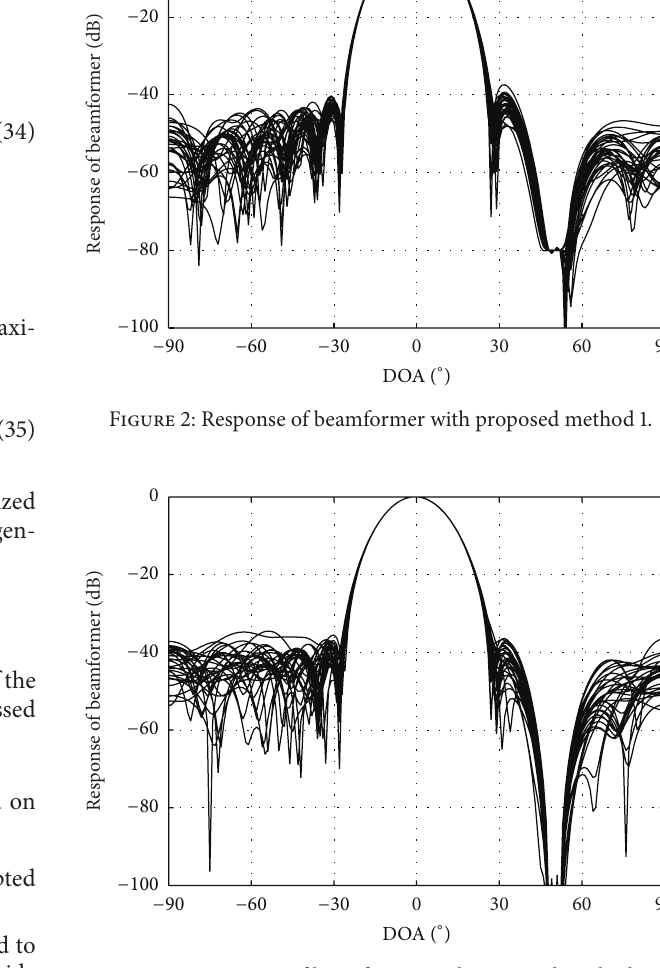
Figure 3: Response of beamformer with proposed method